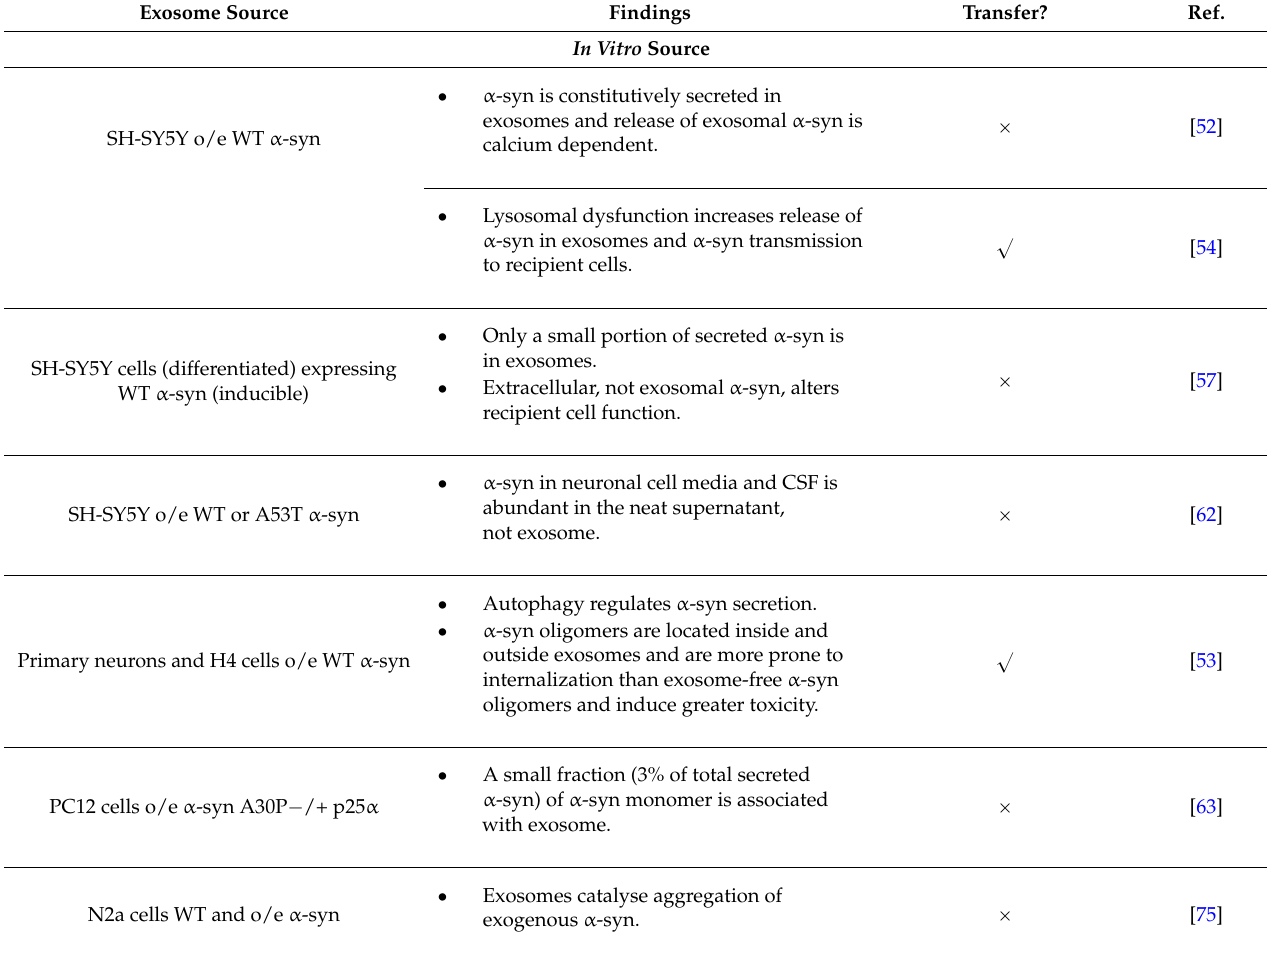
Table 2. Studies pertaining to α -synuclein, exosomes and Parkinson’s